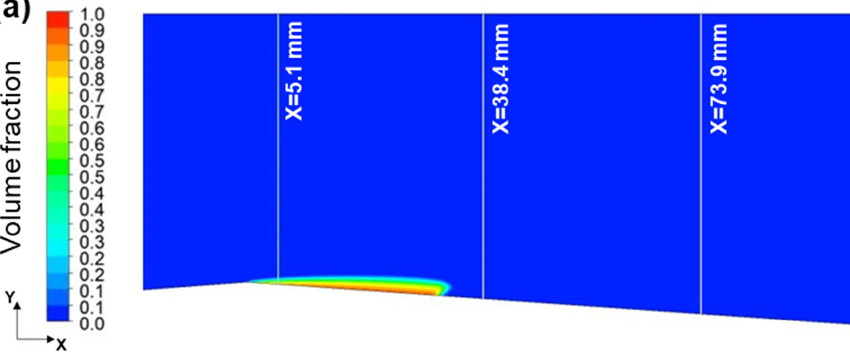
Figure 10. ( a ) Void fractions and ( b ) u-velocity contour .